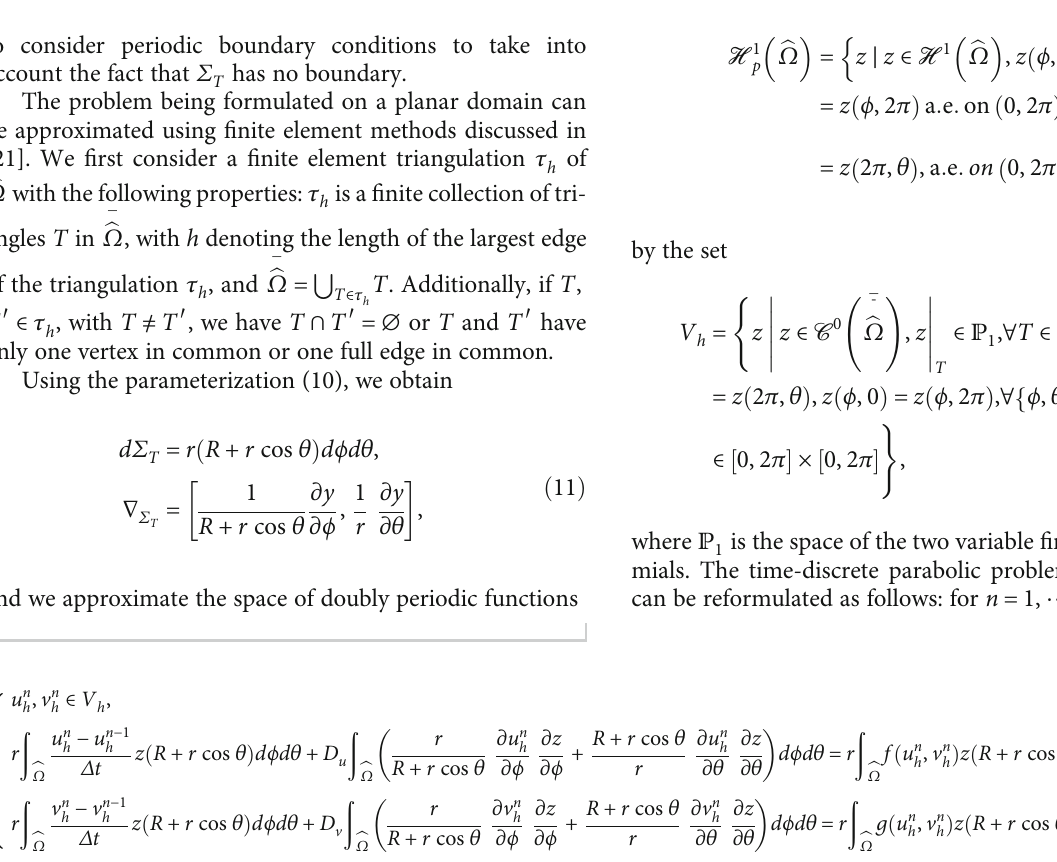
Figure 1: (a) A surface of a torus. (b) Triangulation of